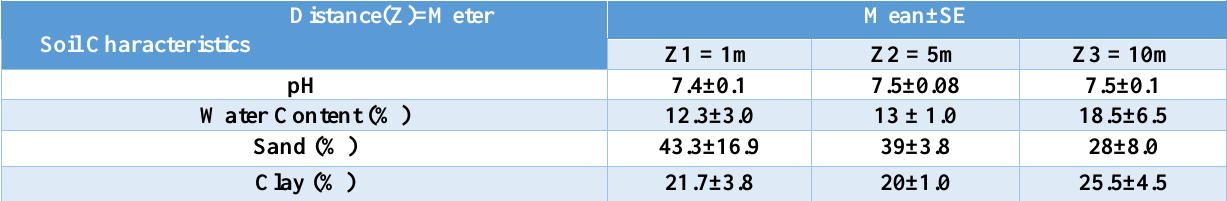
Table, 4: Comparison (mean ±SE ) of the physico-chemical characteristics of the soil at different distances (Z1, Z2, and Z3) collected from the rear (Re) side of the